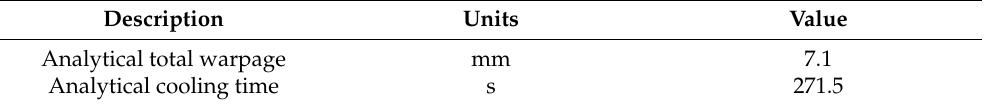
Table 6. Results obtained from the cooling phase analytical model for the cooling system traditional